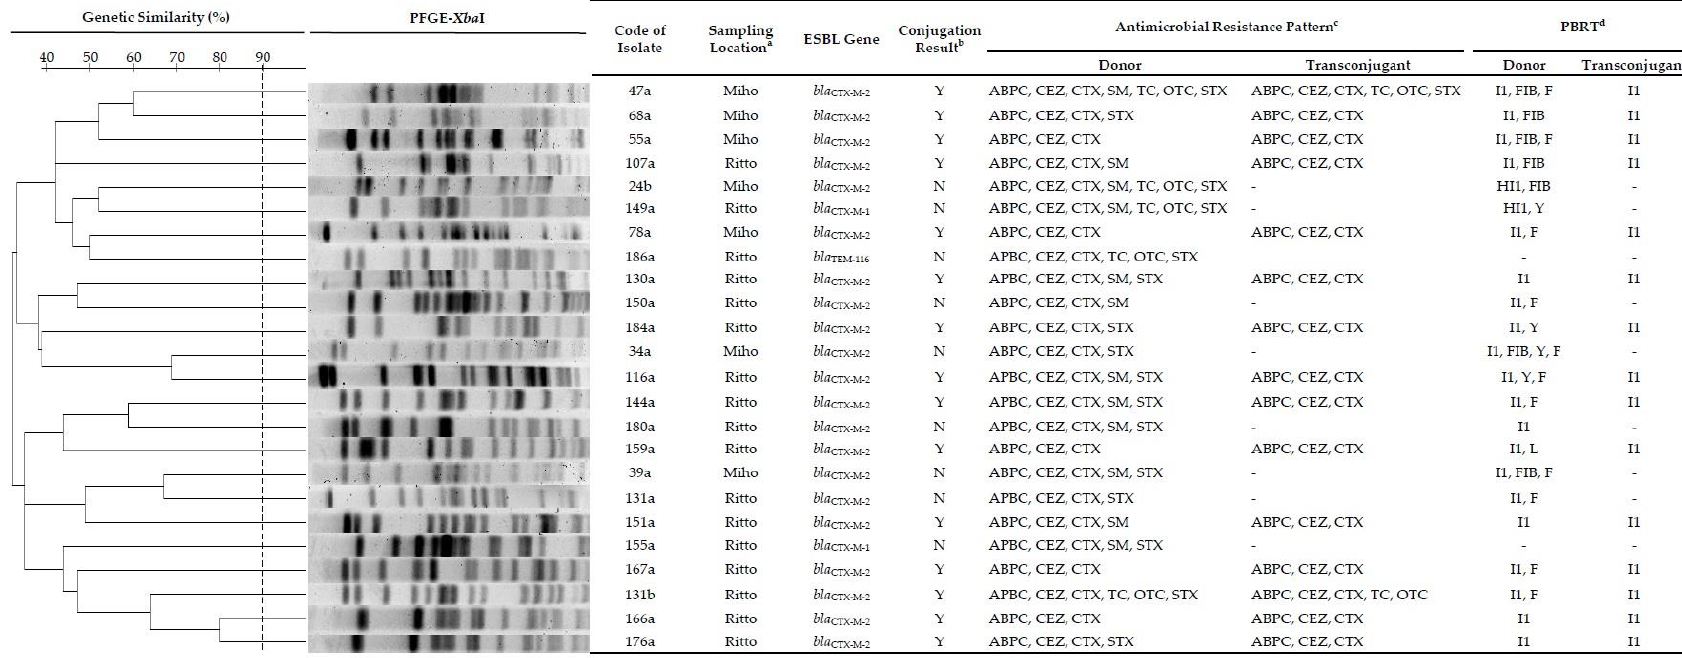
Figure 1. Characterization of extended spectrum β-lactamase (ESBL)-producing E. coli (ESBLECs) isolated from healthy Thoroughbred racehorses and their ability to transfer the ESBL gene. a Miho, Miho Training Center, Japan Racing Association, Ibaraki; Ritto, Ritto Training Center, Japan Racing Association, Shiga. b Y, Successful conjugation; N, Not successful conjugation. c ABPC, ampicillin; CEZ, cefazolin; CTX, cefotaxime; SM, streptomycin; TC, tetracycline; OTC, oxytetracycline; STX, trimethoprim-sulfamethoxazole. Antimicrobial susceptibility test was interpreted using CLSI criteria and JVARM report. d PBRT, PCR-based replicon typing.